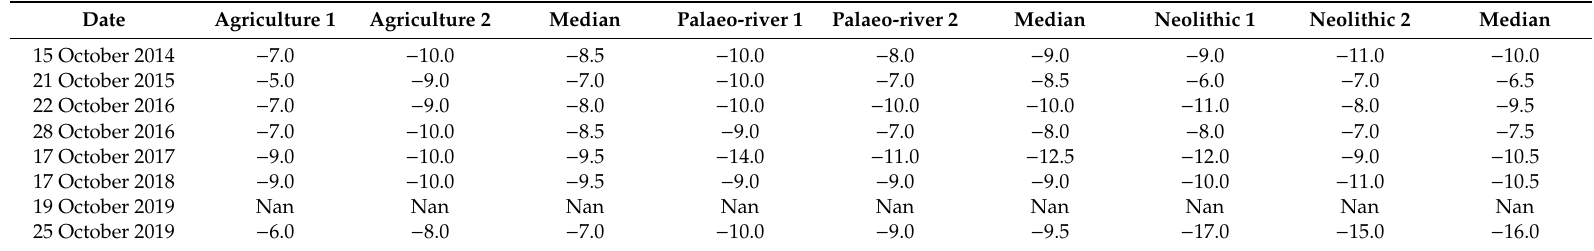
Table A5. Backscatter values for the Sentinel 1 2014, 2015, 2016, 2017, 2018, and 2019 Sigma0-VV